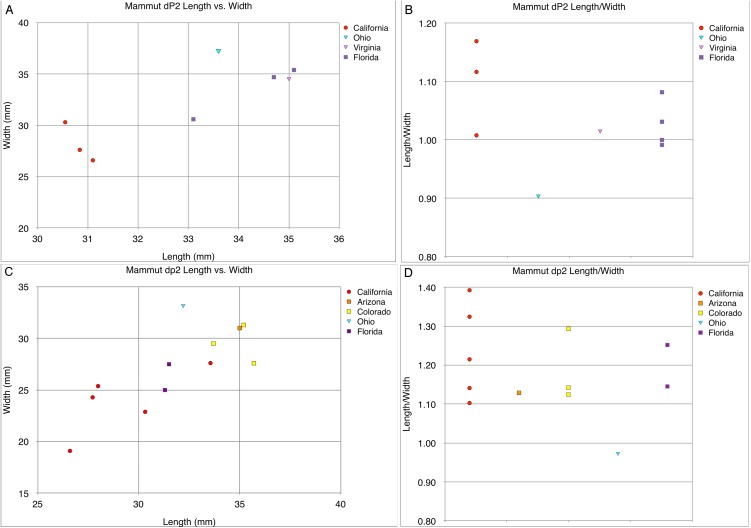
Length and width comparisons of Mammut dP2 and dp2, by state/province/country.(A) Length vs. width of Mammut dP2. M. pacificus is indicated in red, (B) length/width of Mammut dP2, organized by location. M. pacificus is indicated in red, (C) length vs. width of Mammut dp2. M. pacificus is indicated in red, and (D) length/width of Mammut dp2, organized by location. M. pacificus is indicated in red.